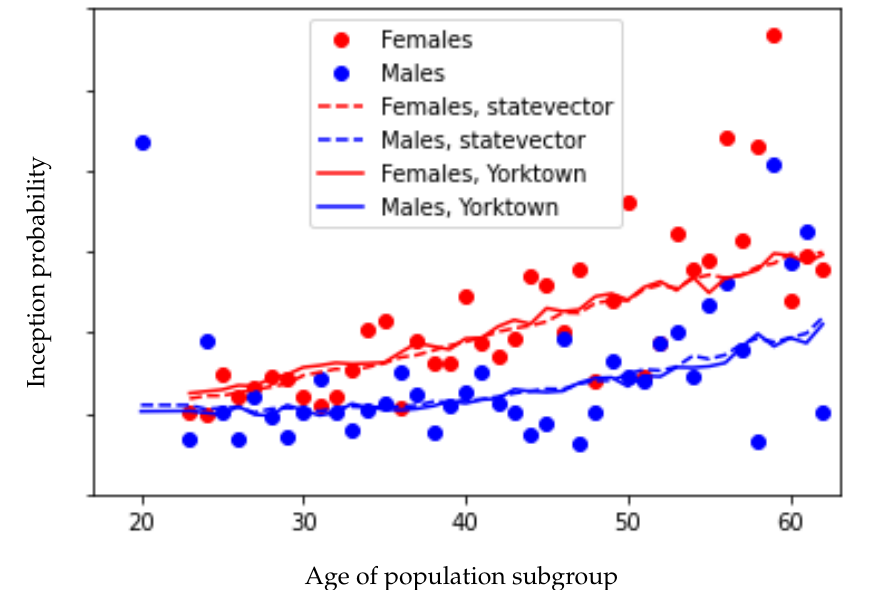
Figure 4. Out-of-sample disability inception rates estimated by state vector simulation and from the IBM Yorktown quantum